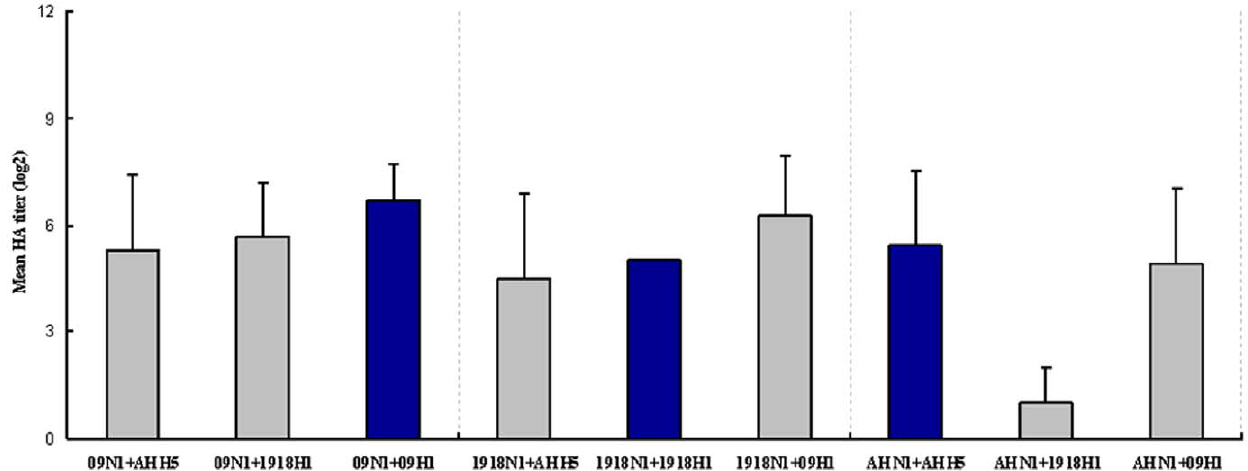
Figure 3. Hemagglination assay of various pps. All pps were two-fold diluted serially in 96-well plate. The hemagglutinating ability was expression as the mean HA titer (log 2 HA units/50 m l) of each pp, n=3.